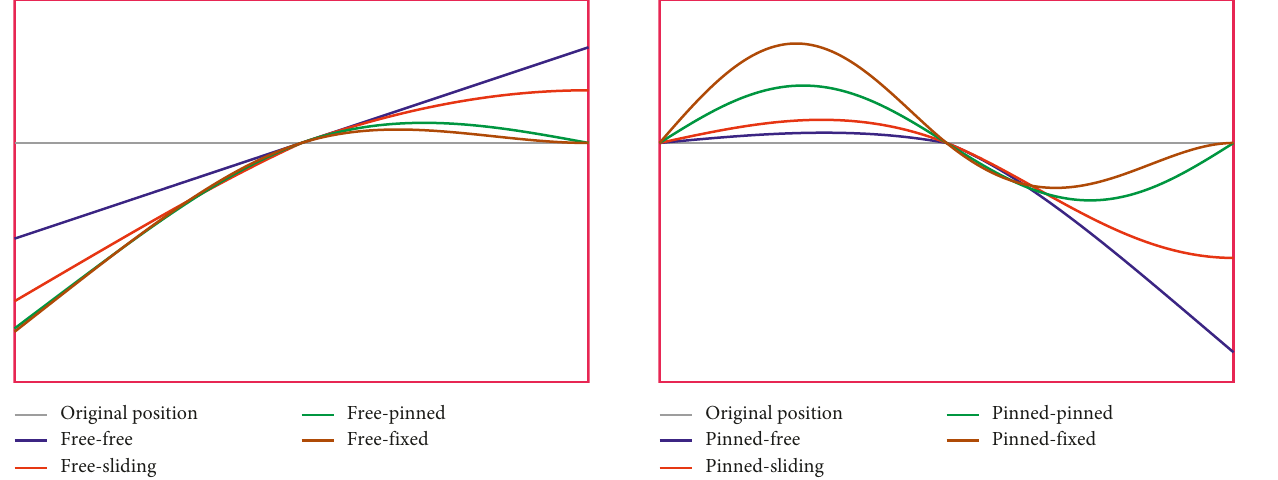
Figure 3: First vibrational modes for two equal span continuous timber floor beams with free left ends and various boundary conditions for right ends.